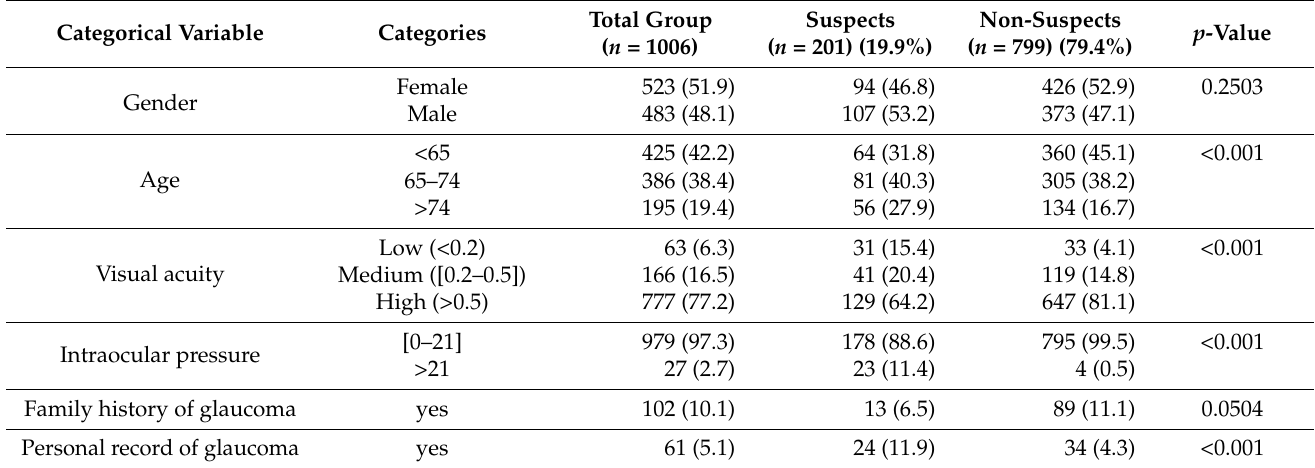
Table 1. Sample characteristics.